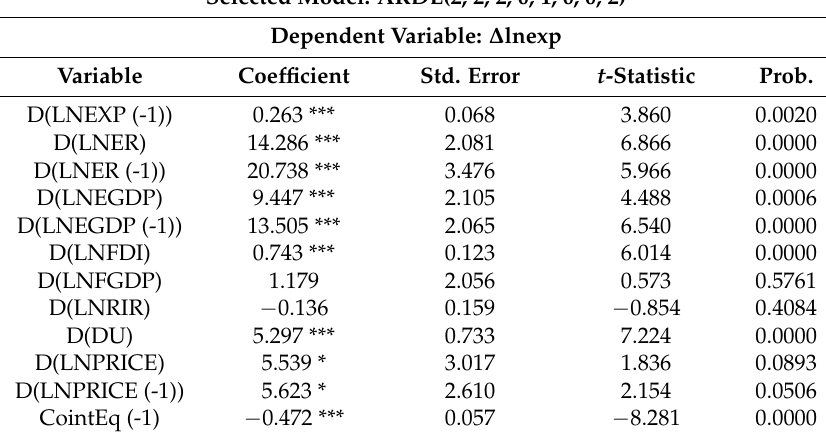
Table 9. Short-run